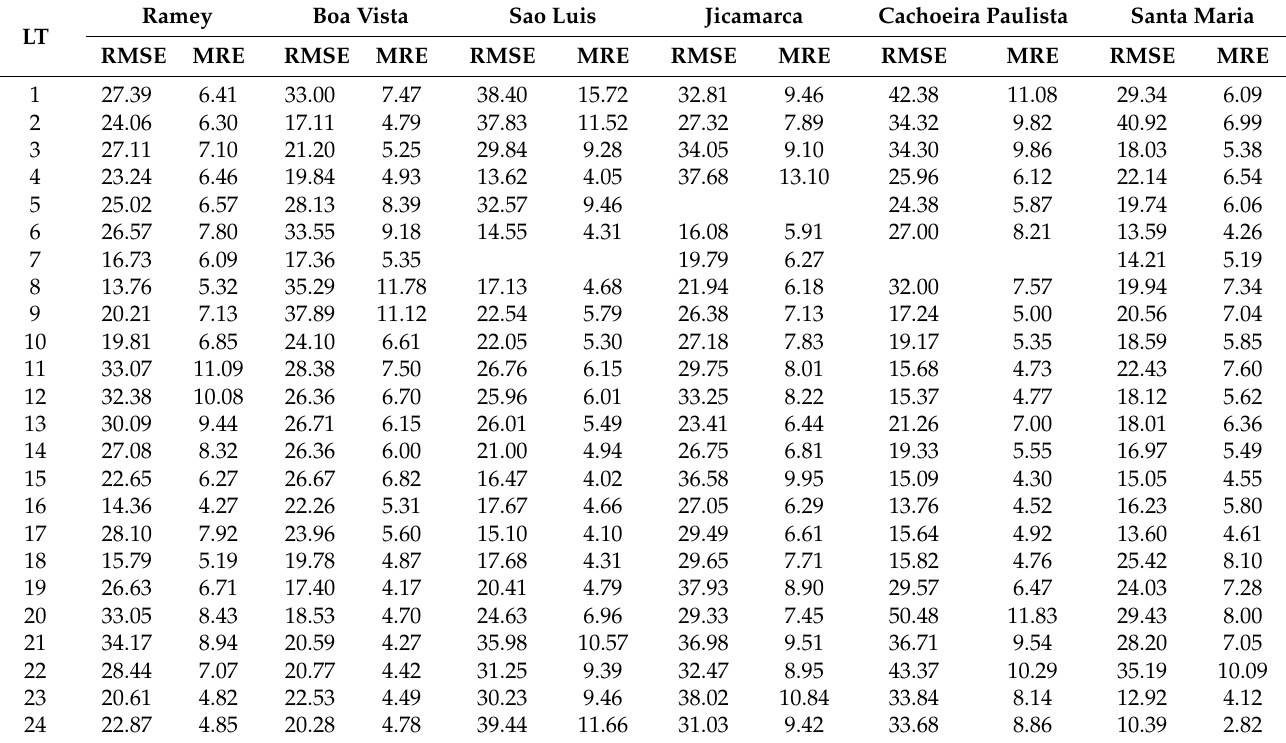
Table A2. Statistics of the differences in h m F 2 obtained from the COSMIC-2 and ionosonde (as the reference) at the six ionosondes under quiet geomagnetic conditions in terms of hourly RMSE (km) and hourly mean |RelE| (MRE, %). Ramey Boa Vista LT